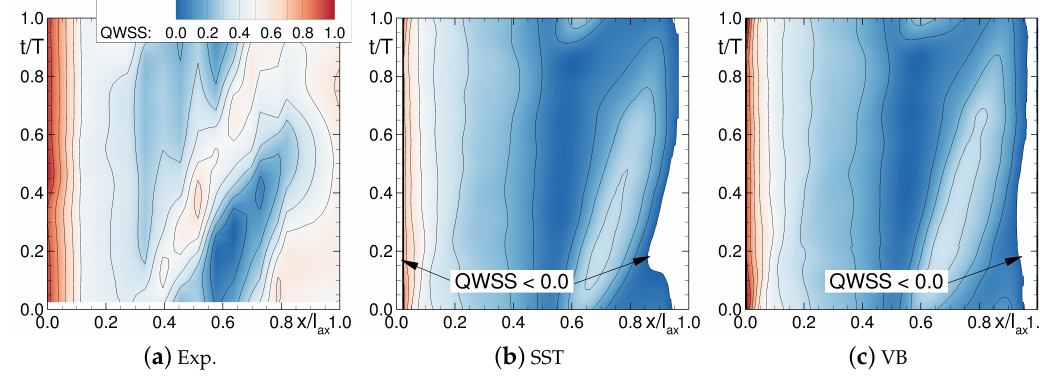
Figure 7. Space-Time Diagrams of quasi wall shear-stress (QWSS) on the Suction Side for the “near choke”